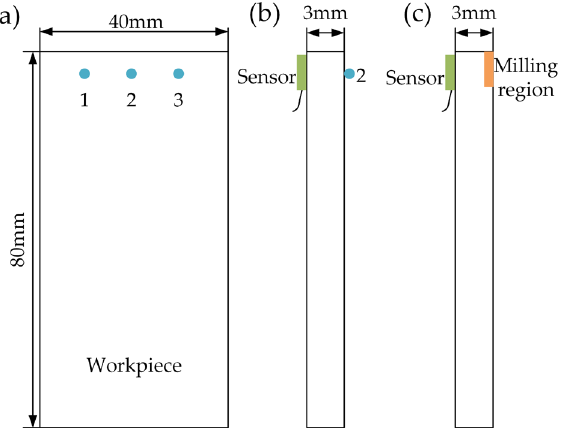
Figure 9. Experimental design. ( a ) Distributed points 1, 2, and 3 on the thin-walled plate for the impact experiments. ( b ) Position of the sensor and point 2 used to measure the response. ( c ) Position of the sensor and tool region for machining.